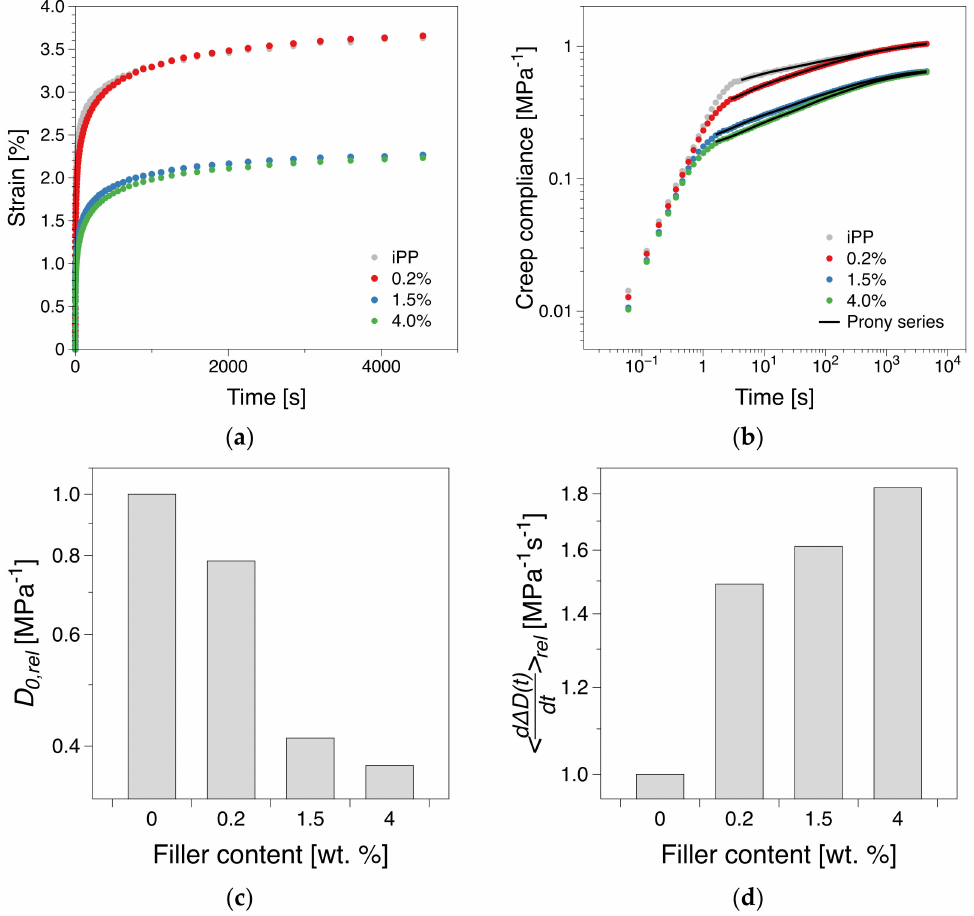
Figure 8. ( a ) Strain and ( b ) creep compliance dynamics during creep testing, and ( c ) the relative instantaneous compliance, D 0, rel , and ( d ) averaged transient rate of creep compliance < d ∆ D ( t ) / dt > rel dependence on filler concentration. A typical error for such determinations is